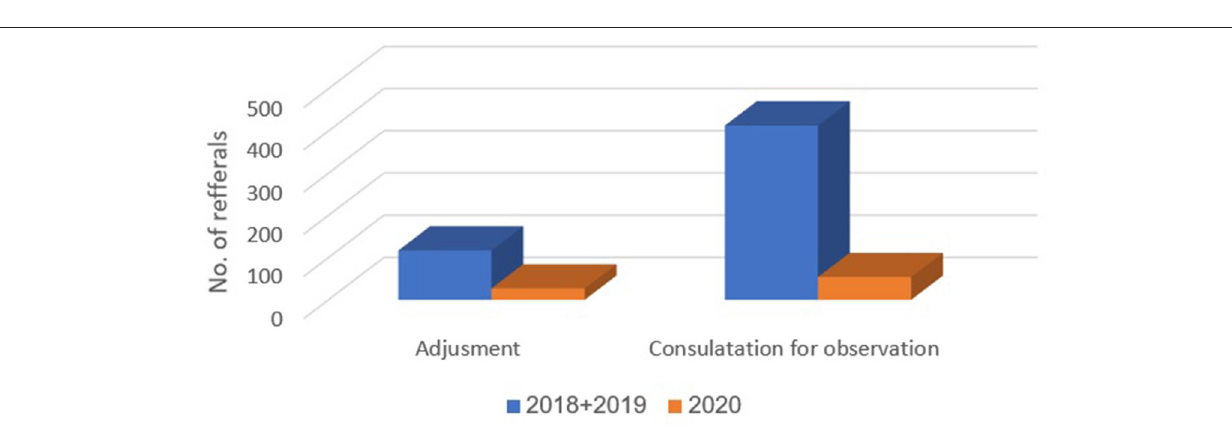
FIGURE 3 | Representation of diagnoses that decreased in proportion of occurrence.